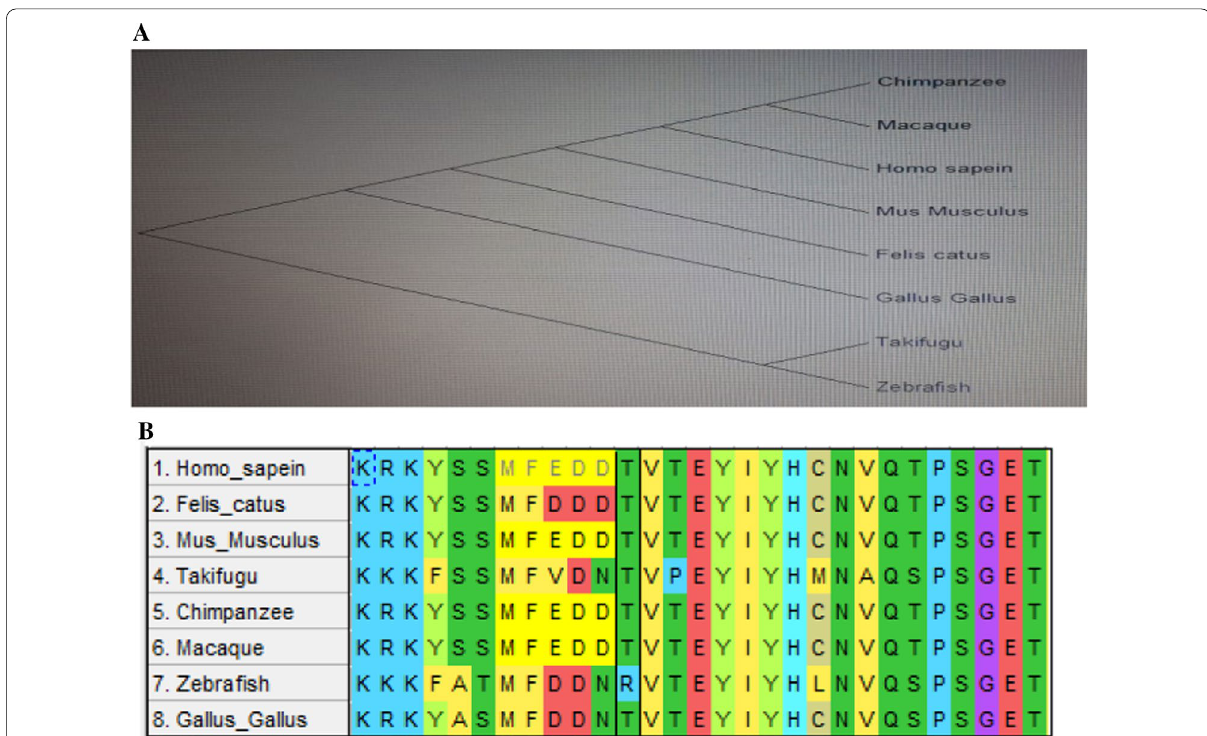
Fig. 4 a Phylogenetic tree shows the conservation of Abhd5 protein in other orthologs (across different species).The evolutionary history was inferred using the Neighbor–Joining method [1]. The optimal tree with the sum of branch length were computed using the Poisson correction method. b Multiple sequence alignment of Abhd5 protein showing high conservation of amino acids across the mutated region of c.730–731insA (p.Thr244Asnfs*10) variation among different species. Mutation position marked in black